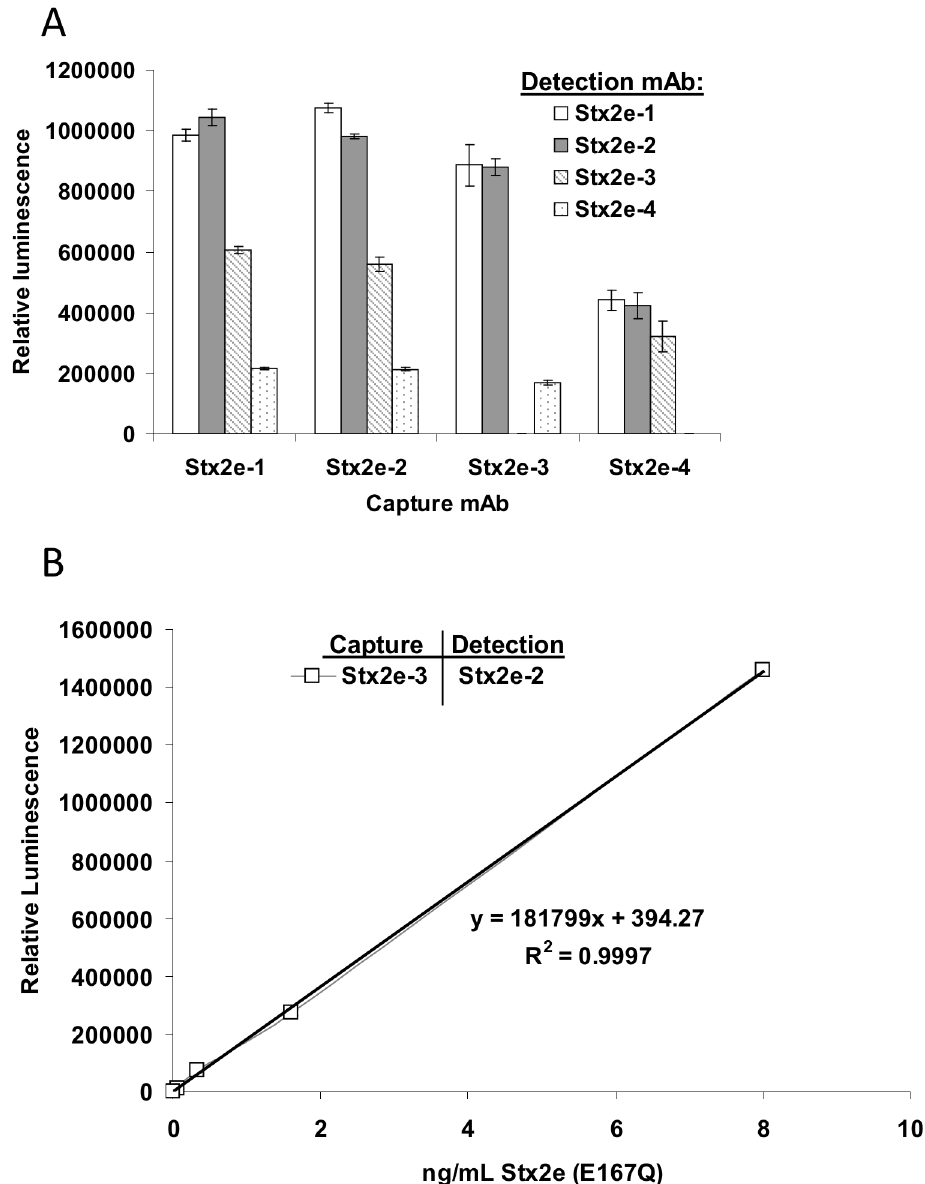
Fig 2. Stx2e ELISA sensitivity and specificity. A) Optimizing sandwich ELISA antibody combinations. Antibodies were used at 1 μ g/mL for capture and 0.5 μ g/mL for detection; Stx2e (E167Q) was used at 10 ng/ mL in PBS. B) Standard curve for the most sensitive anti-Stx2e sandwich ELISA. Stx2e-3 was used for capture (1 μ g/mL); Stx2e-2 was used for detection (0.5 μ g/mL). Purified Stx2e (E167Q) toxoid was used as the antigen. The standard curves were linear from 8 to 0.01